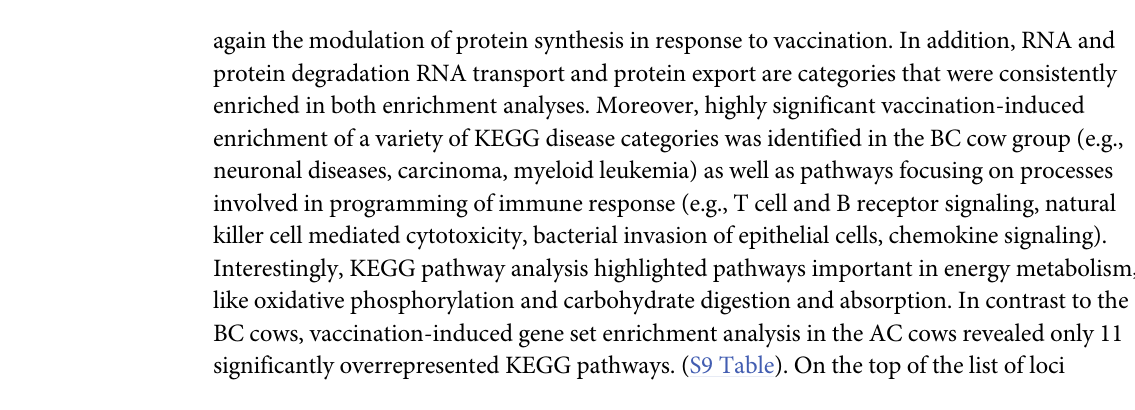
Fig 3. The most significant biological function categories (IPA) affected in cows vaccinated prior to and after calving. Vaccination: Red, prior to calving (BC); green: after calving (AC).